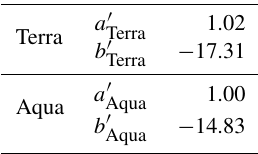
Table 3. Corrected parameterizations of sensible heat flux for the diurnal